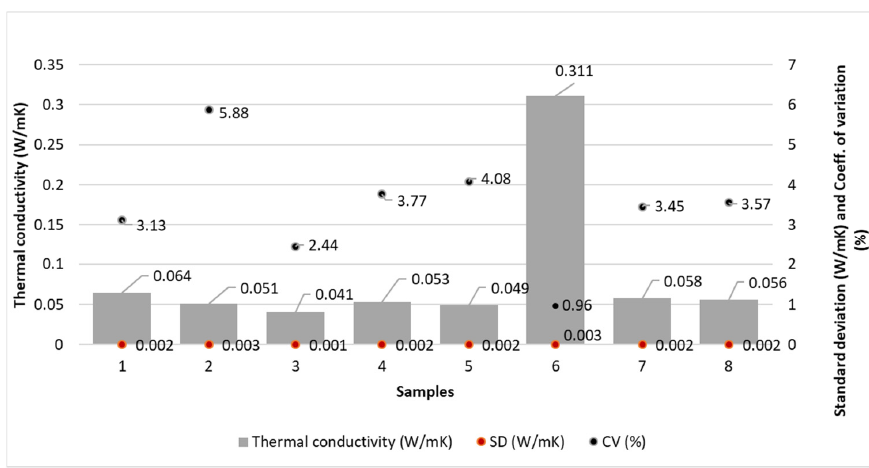
Figure 5. Thermal conductivity of the samples; λ —thermal conductivity, W/mK; SD—standard deviation in W/mK; CV—coefficient of variation, %.